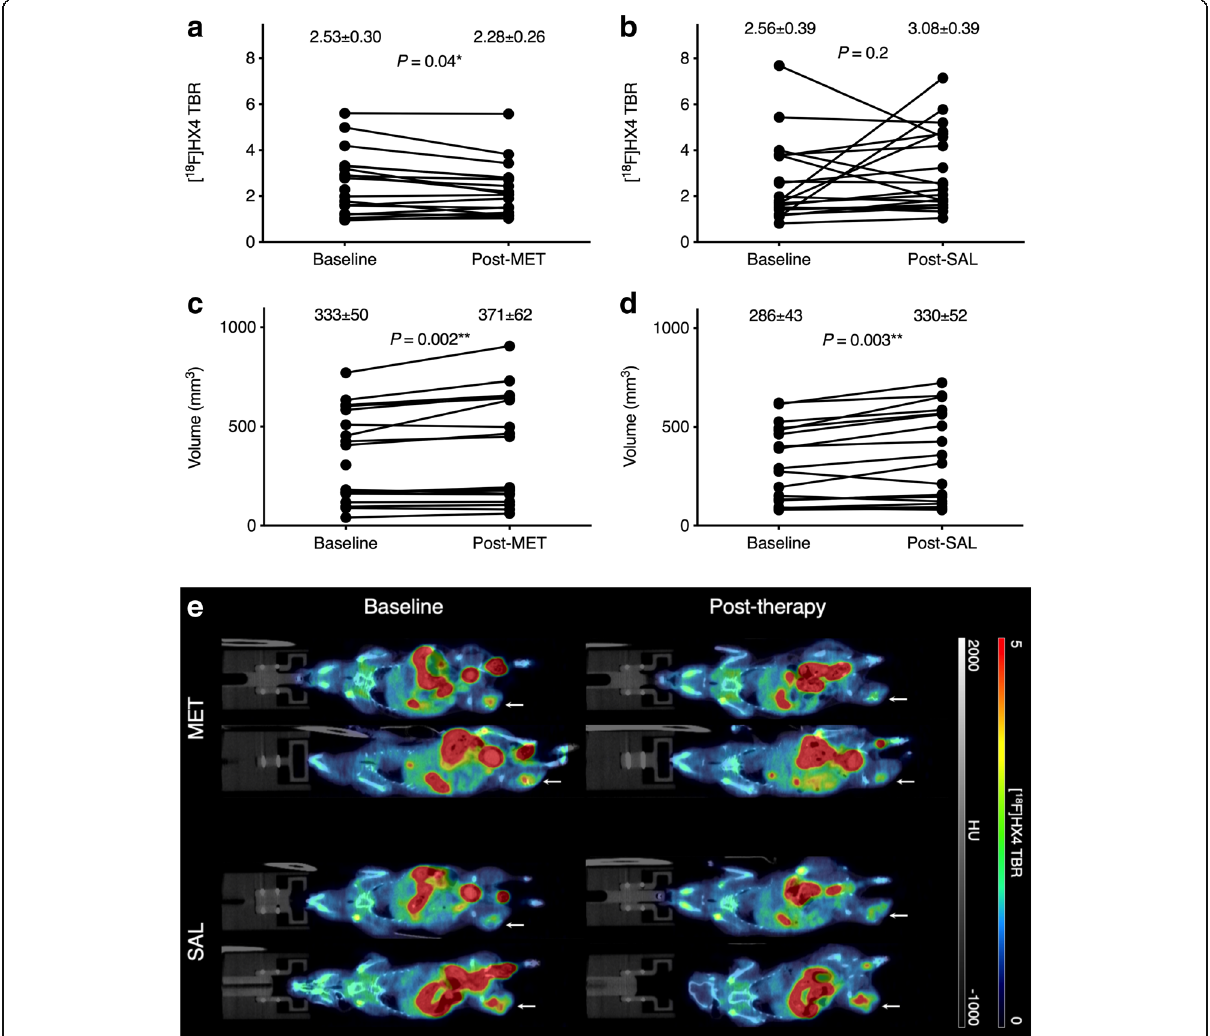
Fig. 2 [ 18 F]HX4 small-animal PET/CT ( μ PET/CT) imaging results. a [ 18 F]HX4 tumor-to-background ratio (TBR) decreased after metformin (MET) administration ( p = 0.04). b Saline (SAL) administration had no influence on tumor hypoxia as measured with [ 18 F]HX4. c Tumor volumes in the metformin cohort significantly increased between the baseline scan and the follow-up scan 24 h later ( p = 0.002). d The same significant increase in tumor volume was measured in the saline cohort ( p = 0.003). e Representative [ 18 F]HX4 TBR-corrected μ PET/CT images of 2 metformin-treated and 2 saline-treated animals before and after metformin administration (coronal view). Arrows indicate tumors. HU, Hounsfield